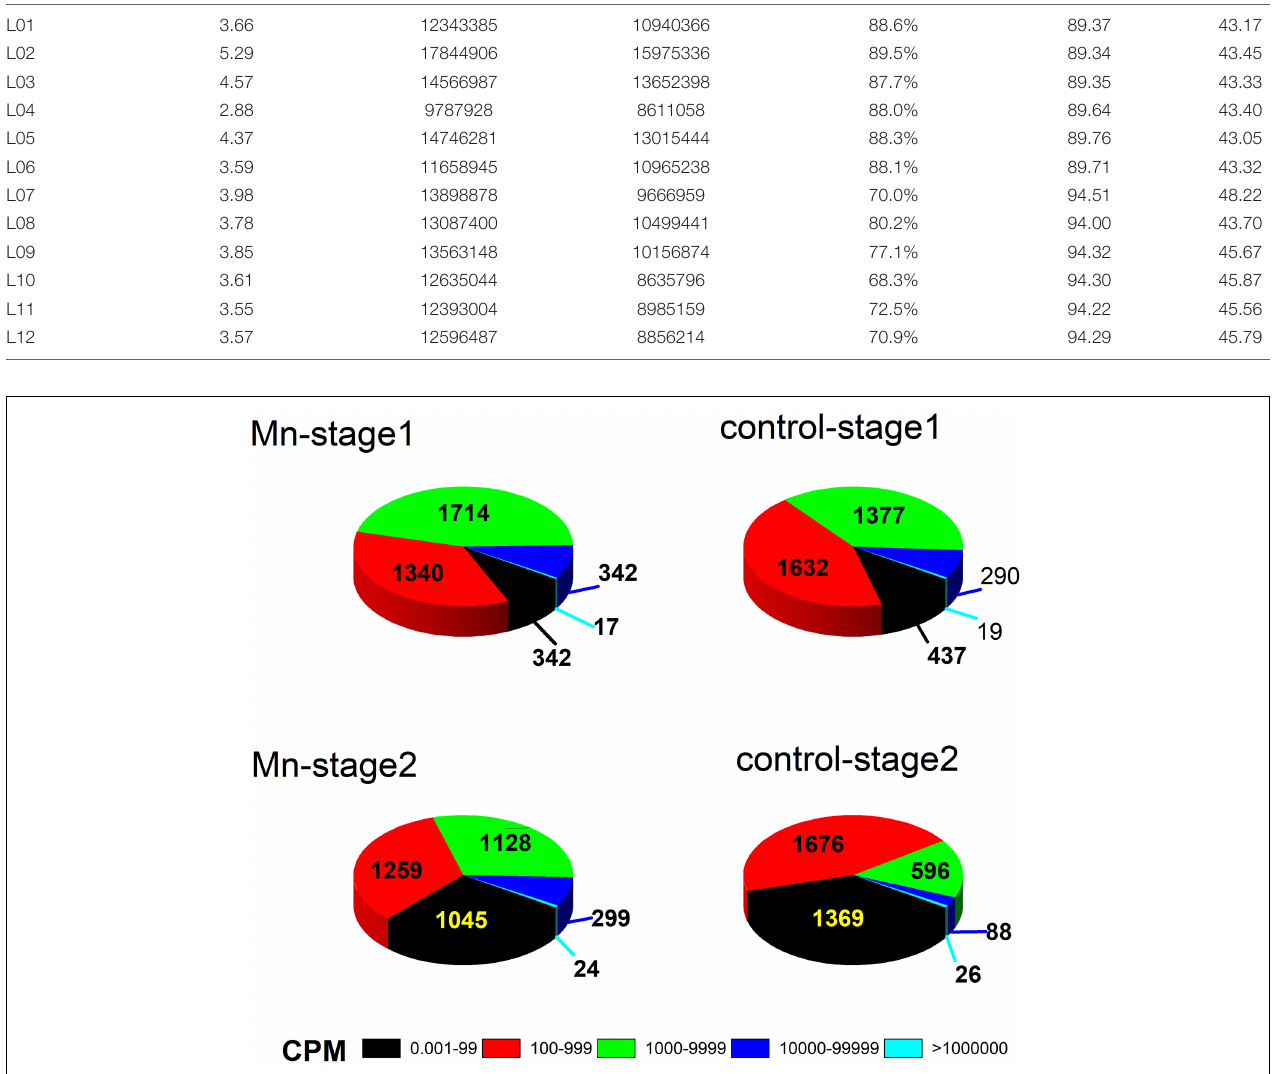
on a homology blast with Bacillus pumilus (Kumar et al., 2016a; Ogonda et al.,